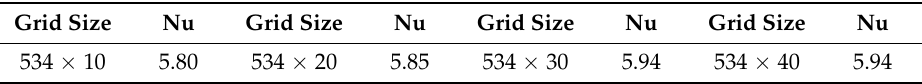
Table 5. Mesh independency